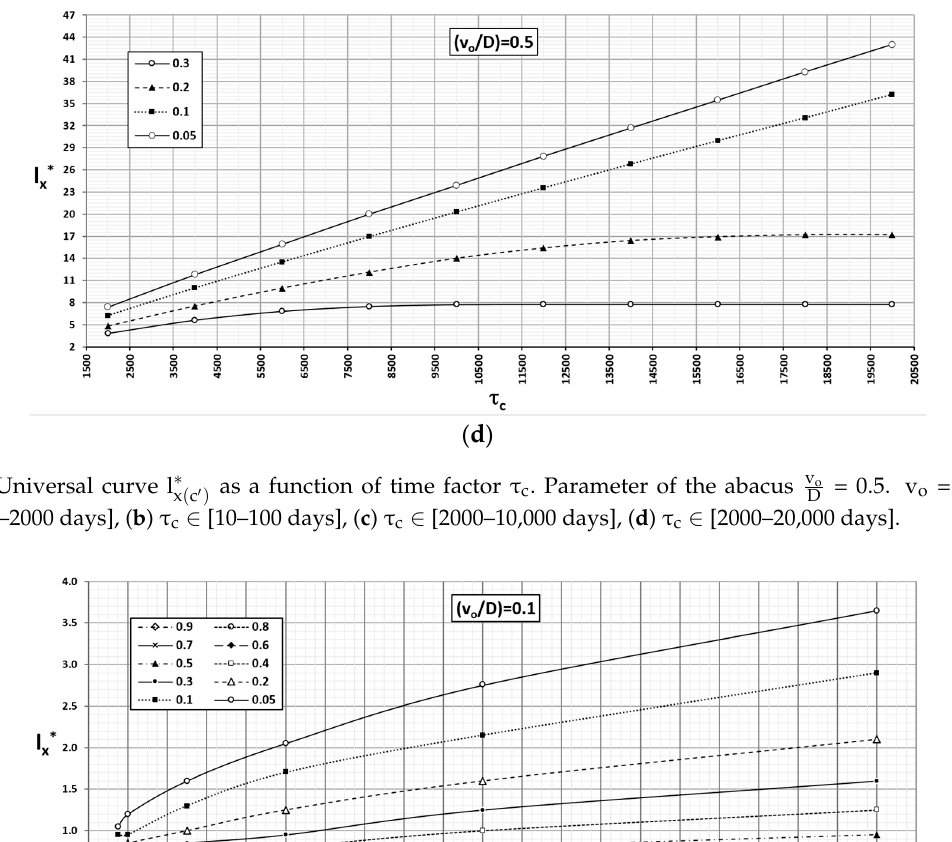
(cid:2913) . Parameter of the abacus